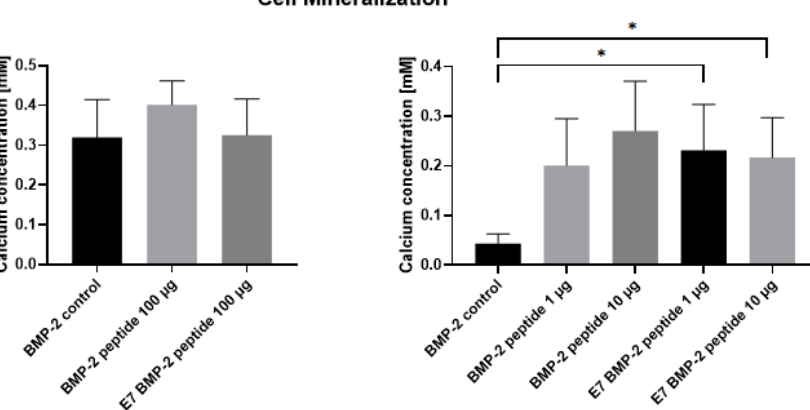
Figure 6. Quantification of JPC mineralization. JPCs were cultivated in the absence or presence of recombinant BMP-2 or BMP-2 mimicry peptides with or without E7-Tag (100 µg/mL) under osteogenic conditions (left panel). After Alizarin staining, calcium concentrations (mM) in JPC quantified. By using BMP-2 mimicry peptides with or without E7-Tag in lower concentrations (1 and monolayers were quantified. By using BMP-2 mimicry peptides with or without E7-Tag in lower 10 µ g / mL, right panel), significant higher JPC mineralization was detected in comparison to BMP-2 concentrations (1 and 10 µg/mL, right panel), significant higher JPC mineralization was detected in control (* p < comparison to BMP-2 control (* p < 0.05).